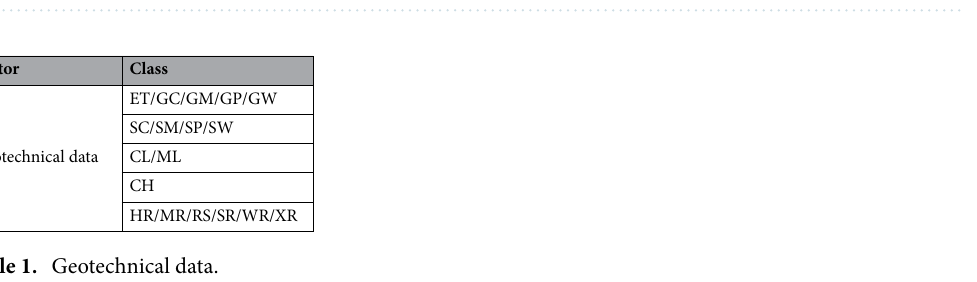
Figure 3. Drilling data visualized in ArcGIS.